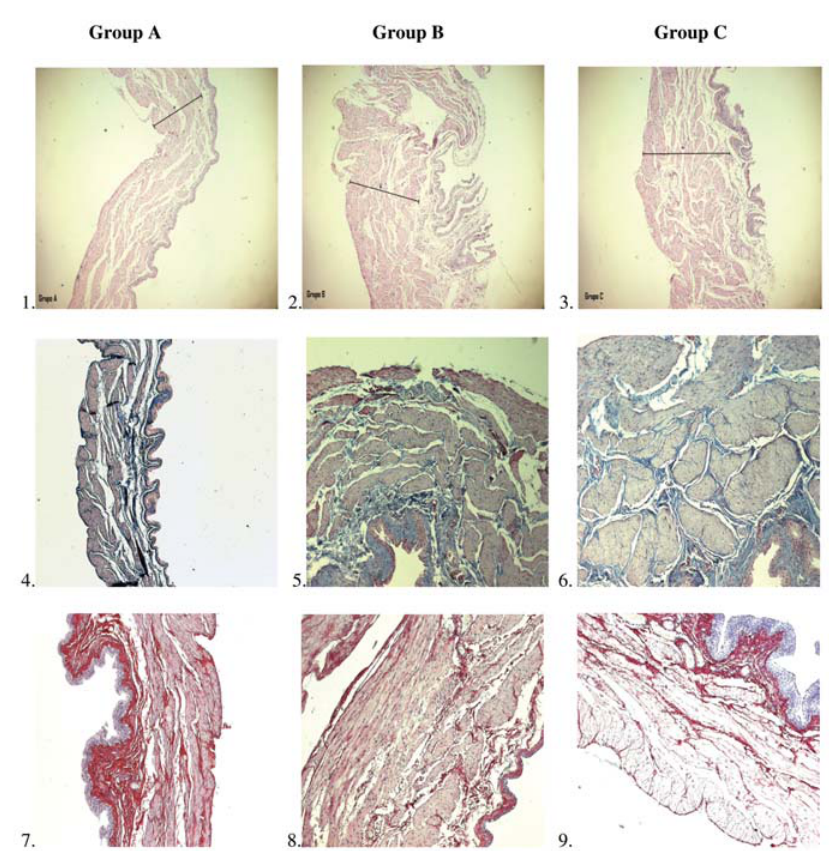
FIGURE 3 - Digital images (100x) from HE (1, 2 and 3), Masson’s trichrome (4, 5 and 6) and pricosirius-red